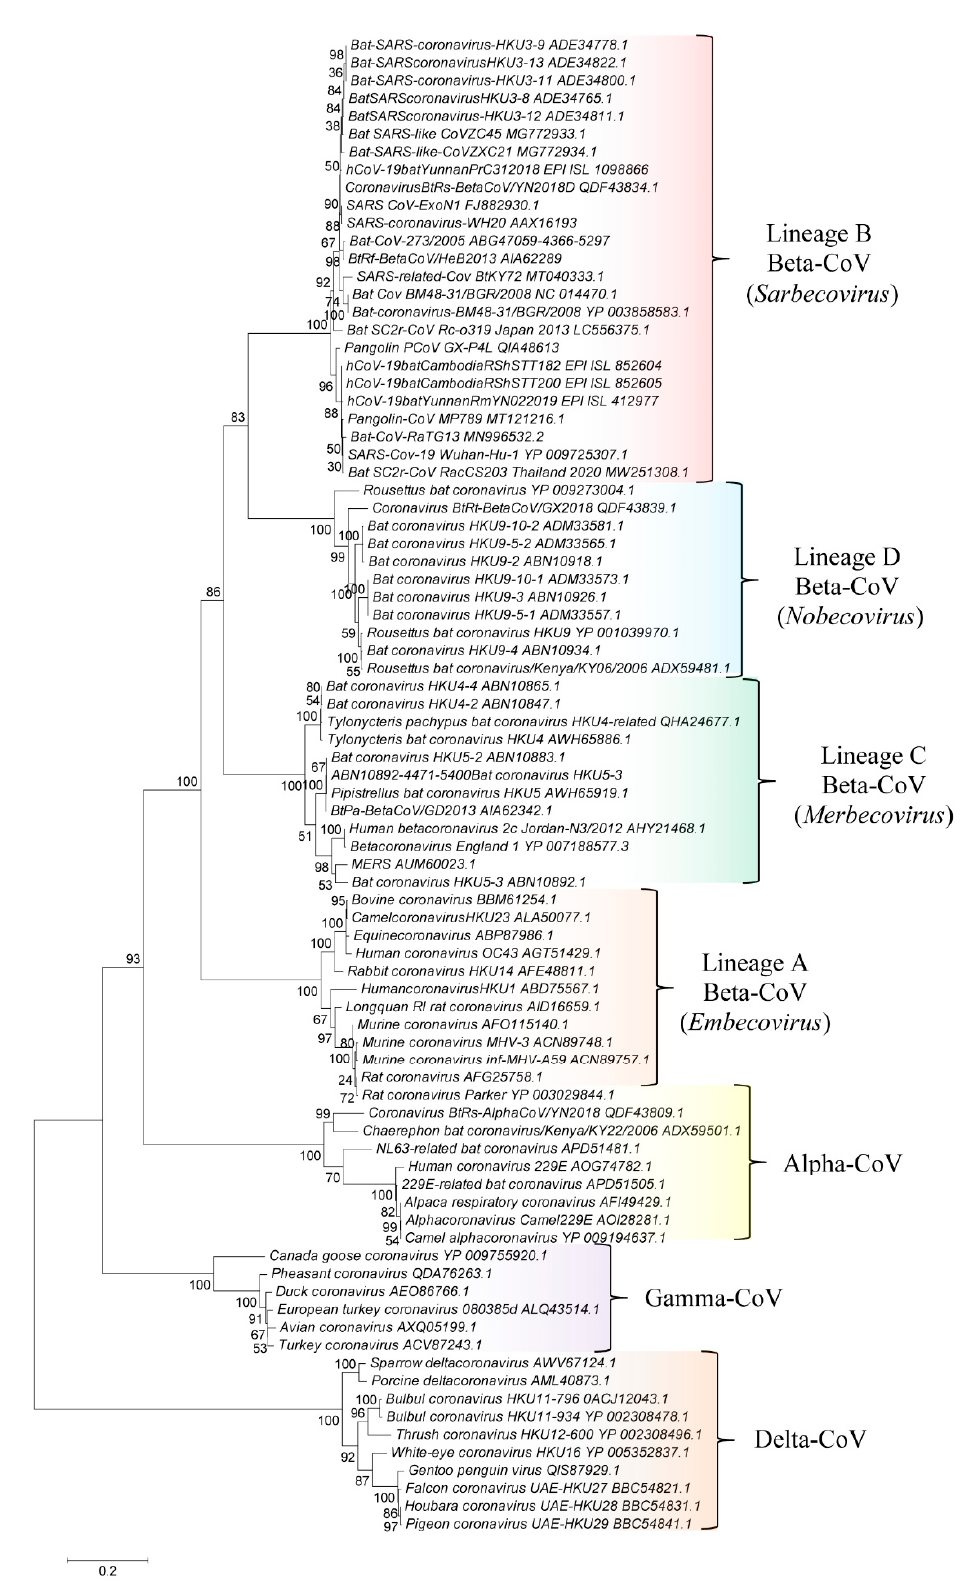
Figure 1. A maximum-likelihood distance tree based on sequence alignment of the RNA- dependent RNA polymerase (RdRp) protein from representative viruses/strains from different genera/subgenera of CoVs. The tree was bootstrapped 100 times and the % bootstraps for different branches are indicated on the nodes. The clades corresponding to different genera and subgenera within the genus Betacoronavirus are